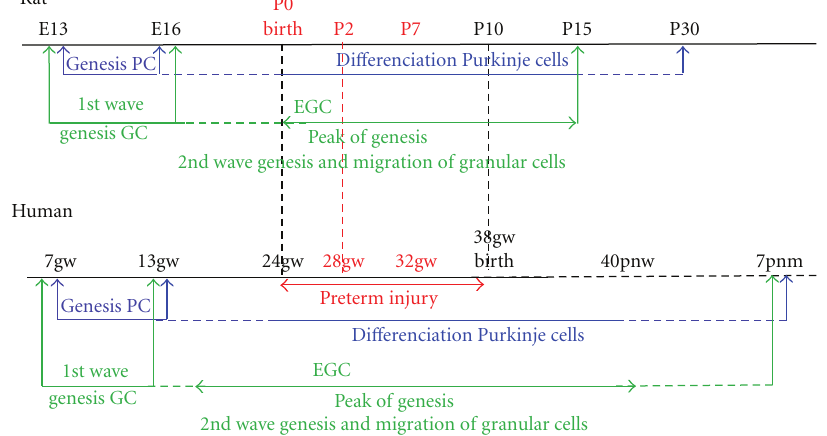
Figure 2: Comparison of timing of development of the Purkinje cells (PC) and granular cells (GC) in the cerebellar cortex in rat and human. EGL: external granular layer. Embryonic day (E), postnatal day 0 (P0), gestational weeks (gw), postnatal weeks (pnw), postnatal months